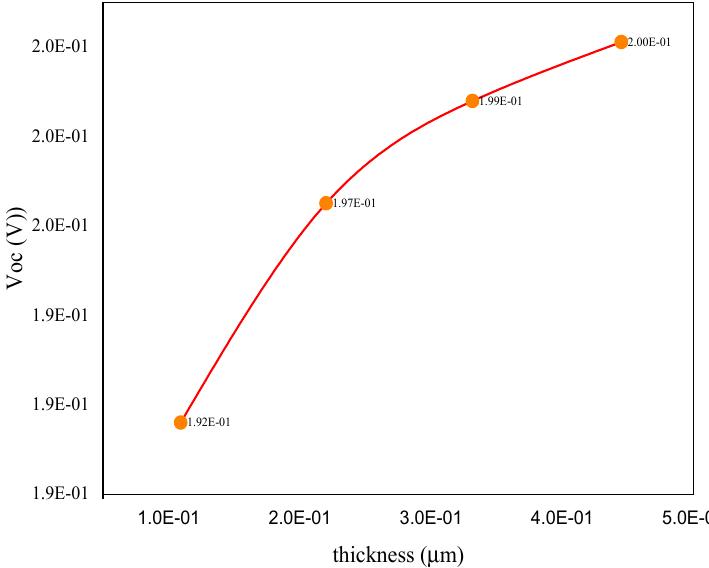
Figure 7. Variation of Voc with perovskite thickness.